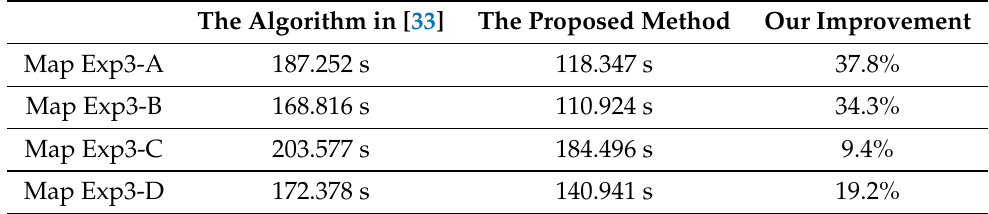
Figure 7. Some additional complete coverage results of the multi-robot system with more complex environment maps. The experiments are carried out using the proposed algorithm with three robots. Table 3. The performance comparison of our proposed technique with the algorithm presented by Pereira et al.